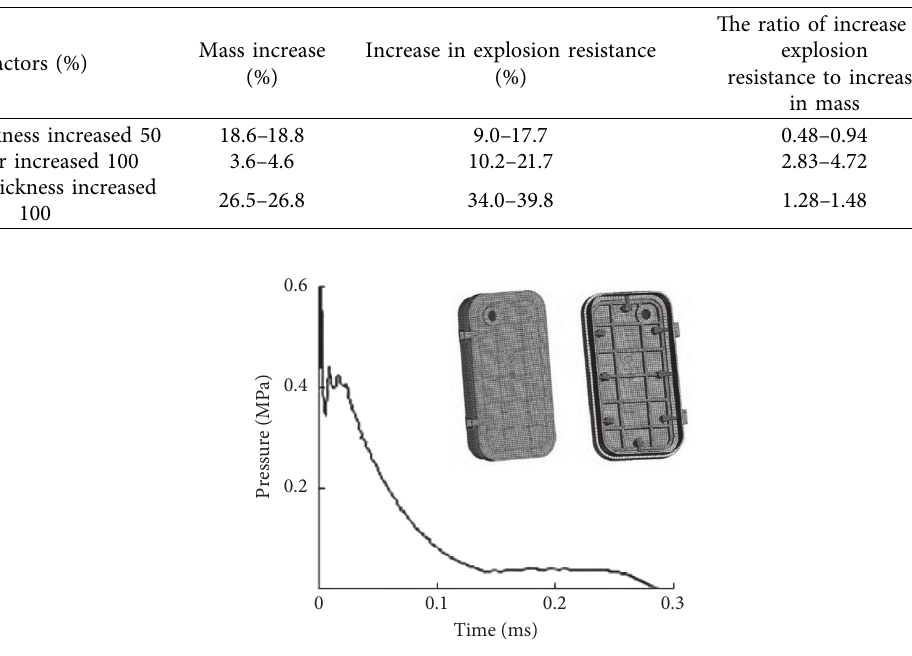
Table 1: Mass and explosion resistance increase table under different factors [31].